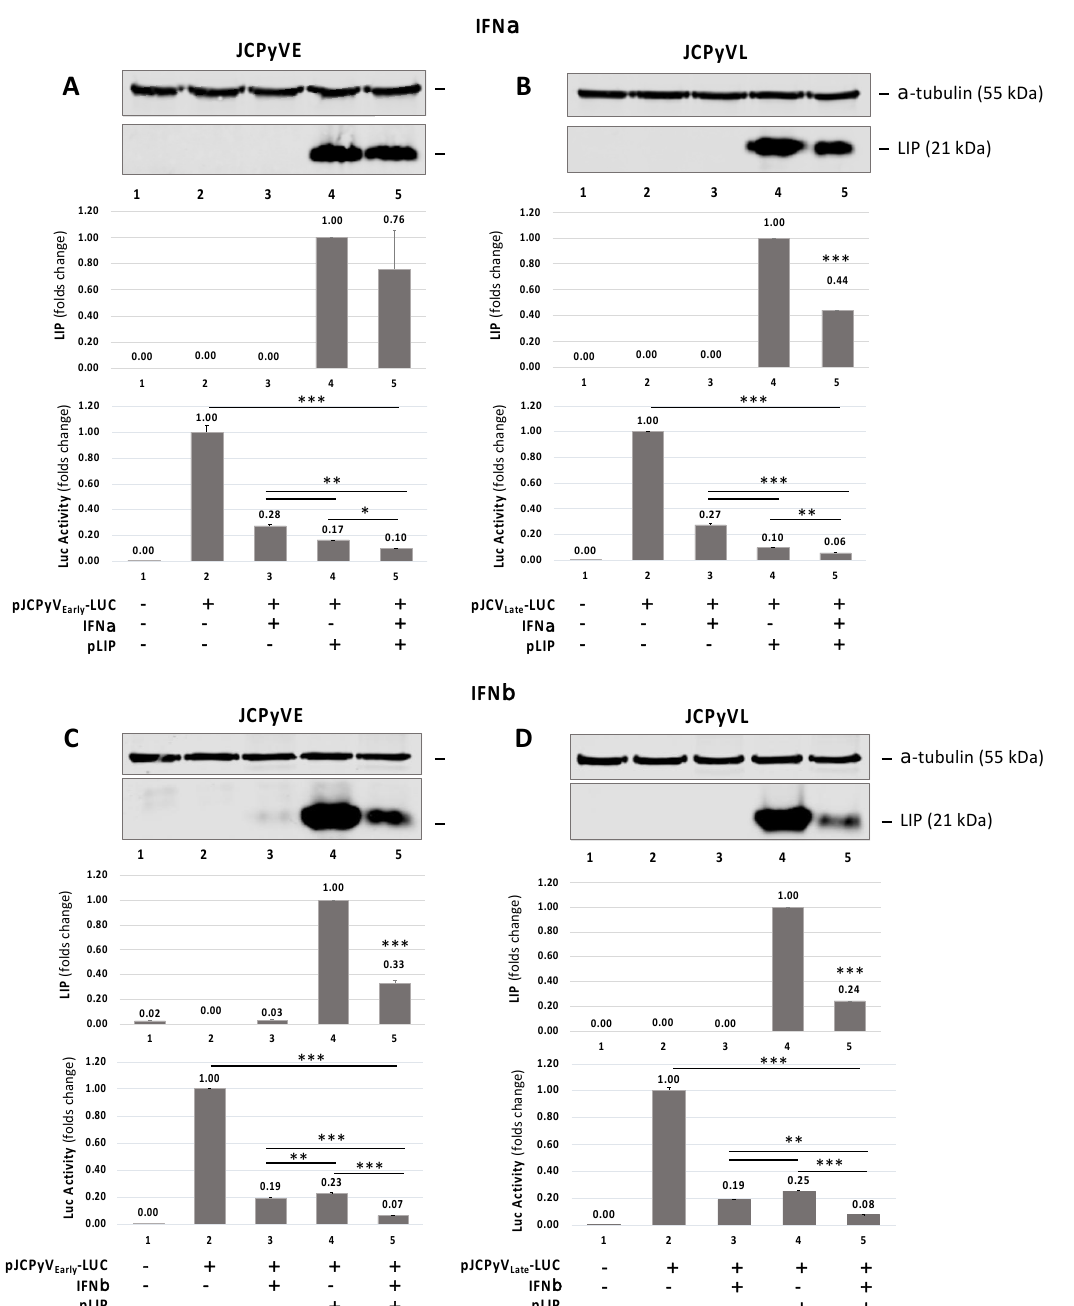
Figure 3. Effect of pCMV-C/EBP β -LIP (pLIP) expression plasmid and IFN α and IFN β on JCPyV early and late promoter activity. Western blot on protein lysis from TC620 cells co-transfected with pLIP expression plasmid and JCPyVE ( A , C ) or JCPyVL ( B , D ) reporter plasmid (containing the full-length NCCR of JCPyV Mad-1 strain cloned immediately upstream